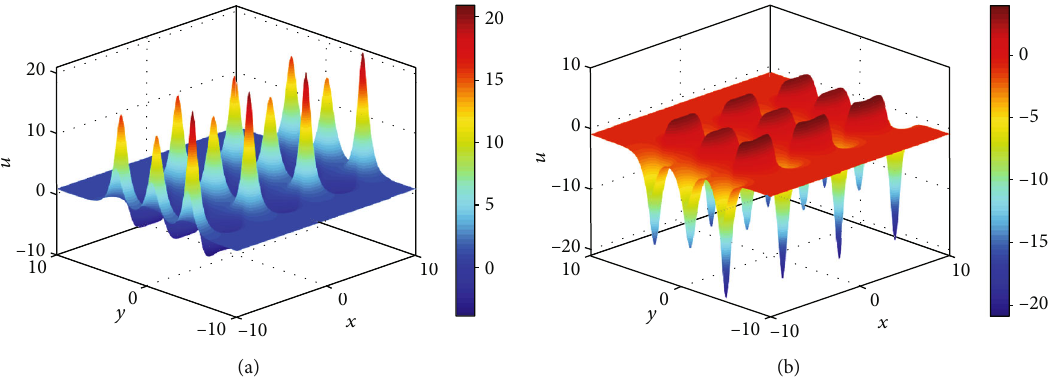
= 1 , b = − 1 , k = − i , k = i , p = 2 , p = 2 , k = i , k = − i , 0 1 2 3 4 1 2 = 1 0